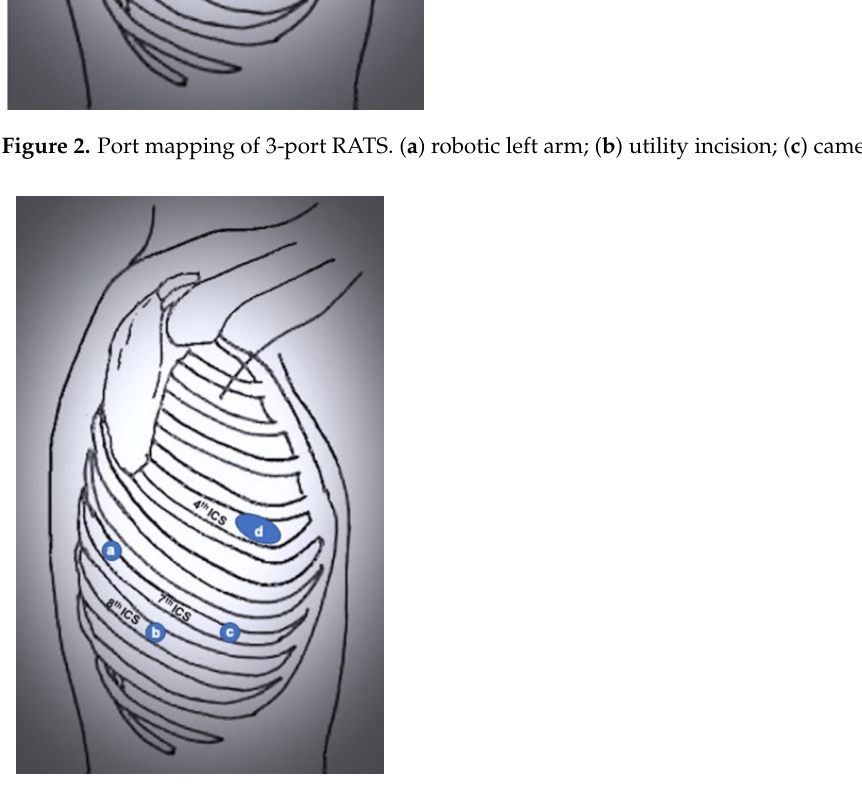
Figure 3. Port mapping of 4-port RATS. ( a ) robotic left arm 1 (lung retraction); ( b ) robotic left arm 2; ( c ) camera port; ( d ) utility port.